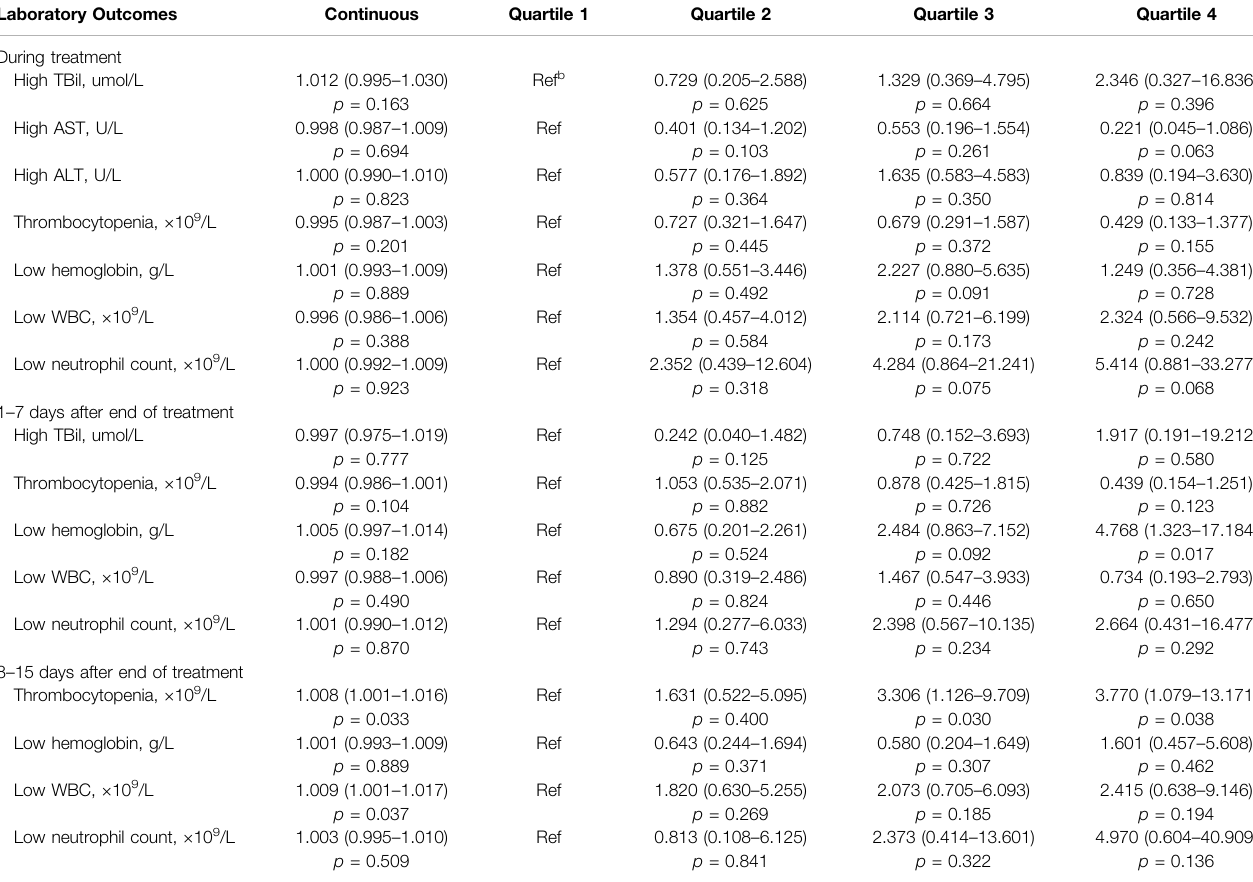
TABLE 4 | Association between AUC 24 and the laboratory adverse events during treatment, and 1 – 7 days, 8 – 15 days after the end of linezolid administration a